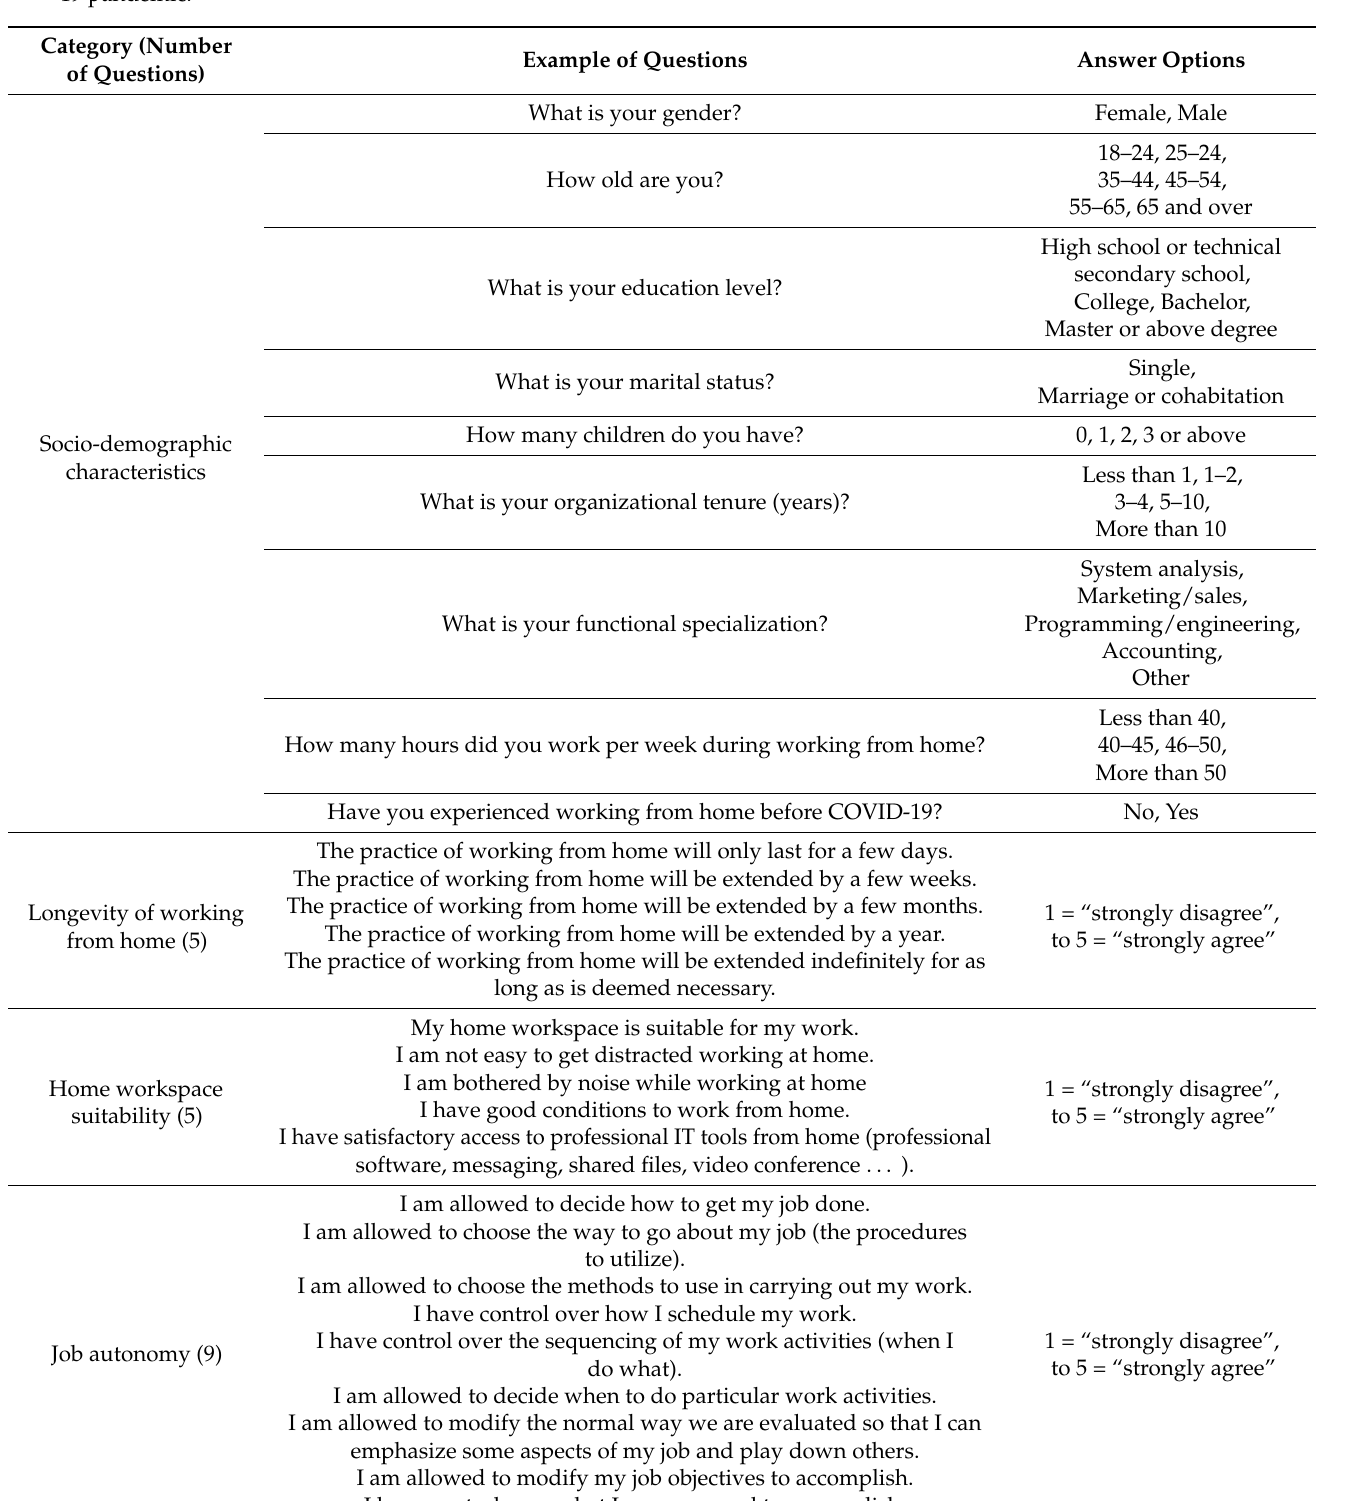
Table A2. Part B of the questionnaire on working from home arrangements and job satisfaction during the COVID- 19